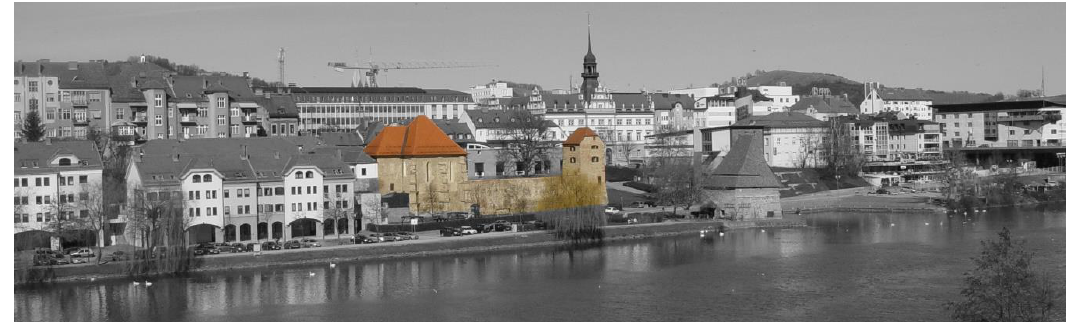
Figure 3. Maribor Synagogue with the Jewish tower and the left bank of the Drava—view from the southwest. Exterior. Photo: Janez Premk.